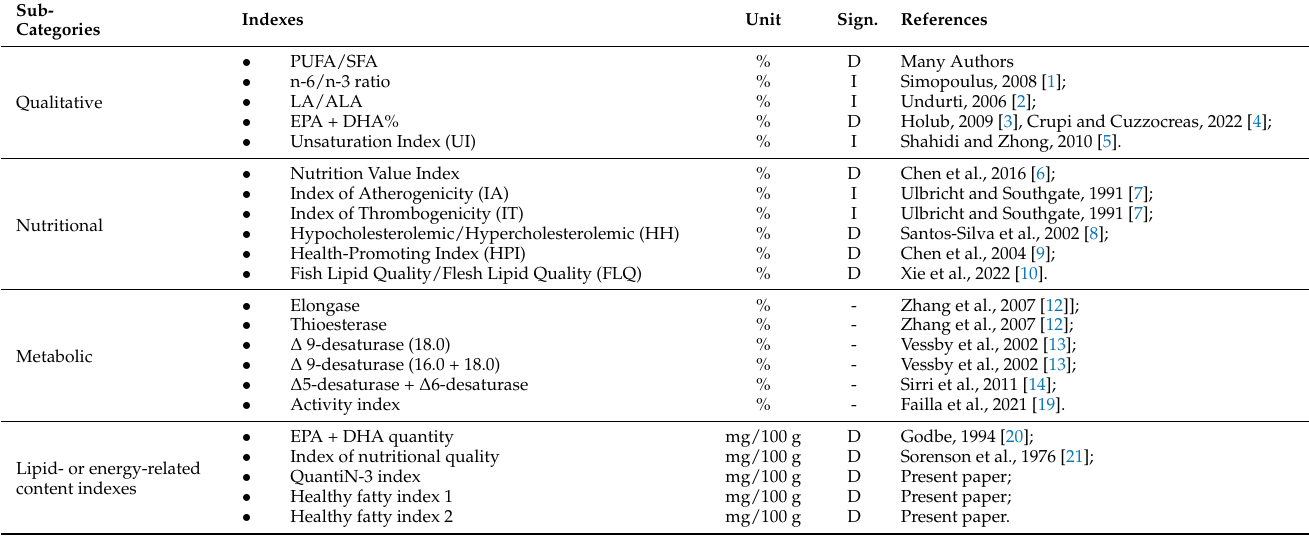
Table 2. Summary of the studied indexes and their significance regarding health effects (D = direct; I =